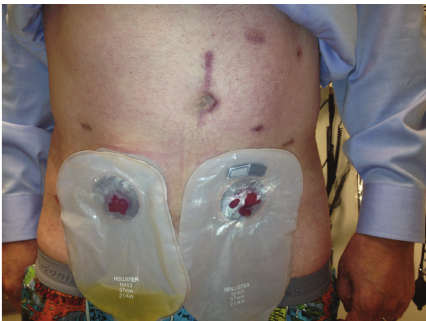
Figure 1: Postoperative surgical result: Case 2. Abdominal image of MITPE patient at one-month postoperative appointment reveal- ing well-healed incisions with associated ileal conduit and end